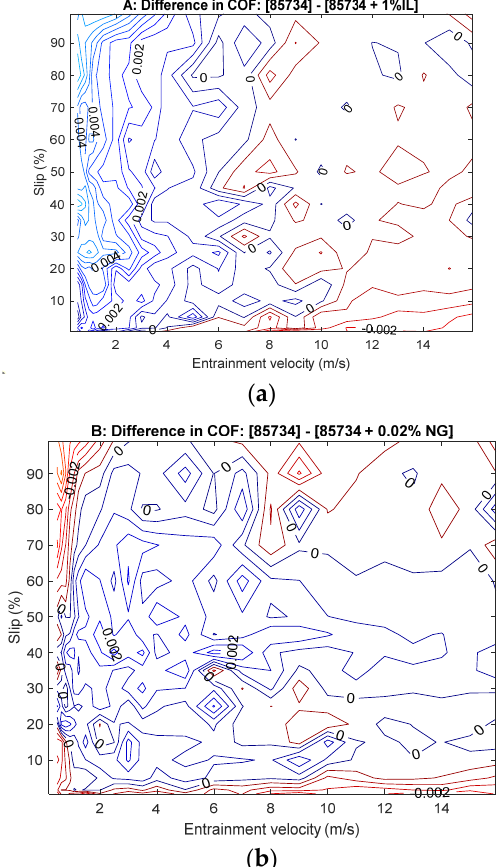
Figure 6. Difference in COF under different contact velocity conditions between the lubricant blends and baseline lubricant. ( a ) 85734 and 85734 + 1 wt.% IL, ( b ) 85734 and 85734 + 0.02 wt.% nanoscale graphene (NG).